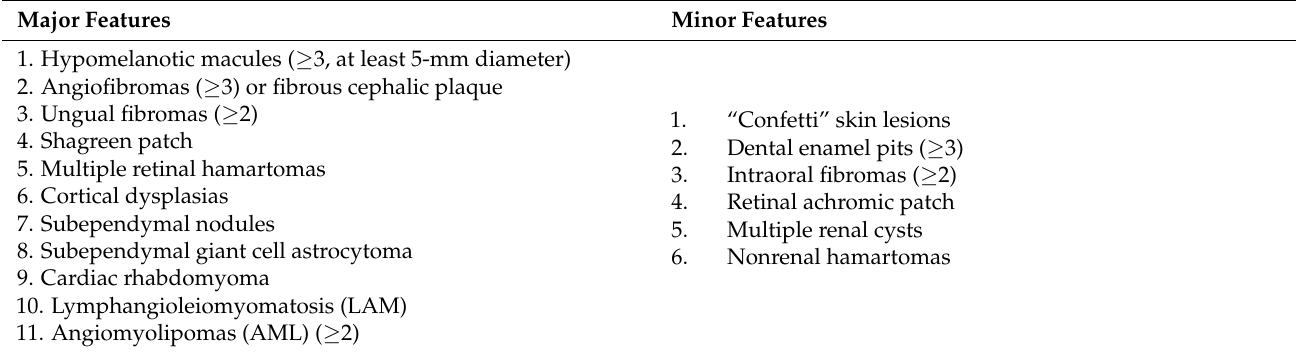
Table 3. Diagnostic criteria for tuberous sclerosis [105].